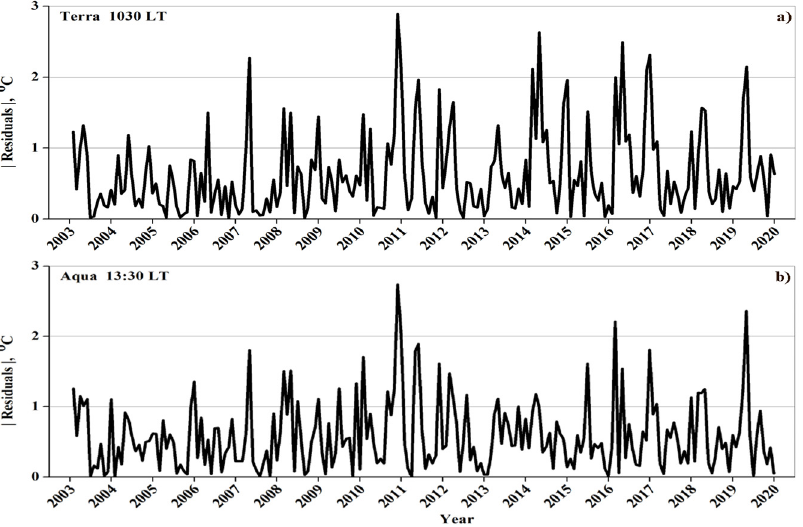
Figure 6. Monthly variations of absolute values of residuals with respect to the obtained linear fit of ( a ) MODIS/Terra and ( b ) MODIS/Aqua surface water temperatures.